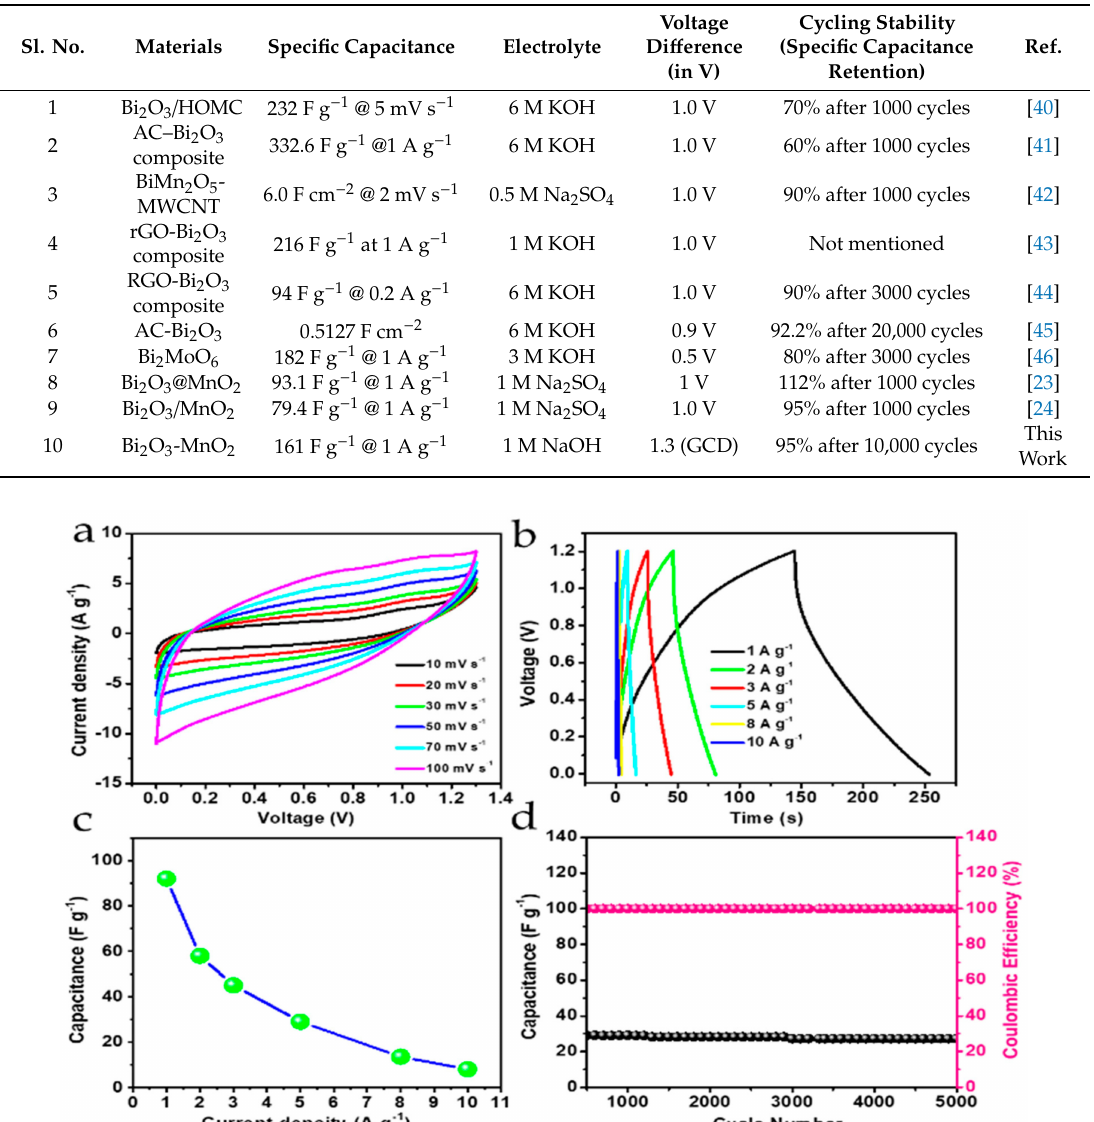
Table 1. A summary of electrochemical performance for Bi 2 O 3 based composite material. Sl. No.